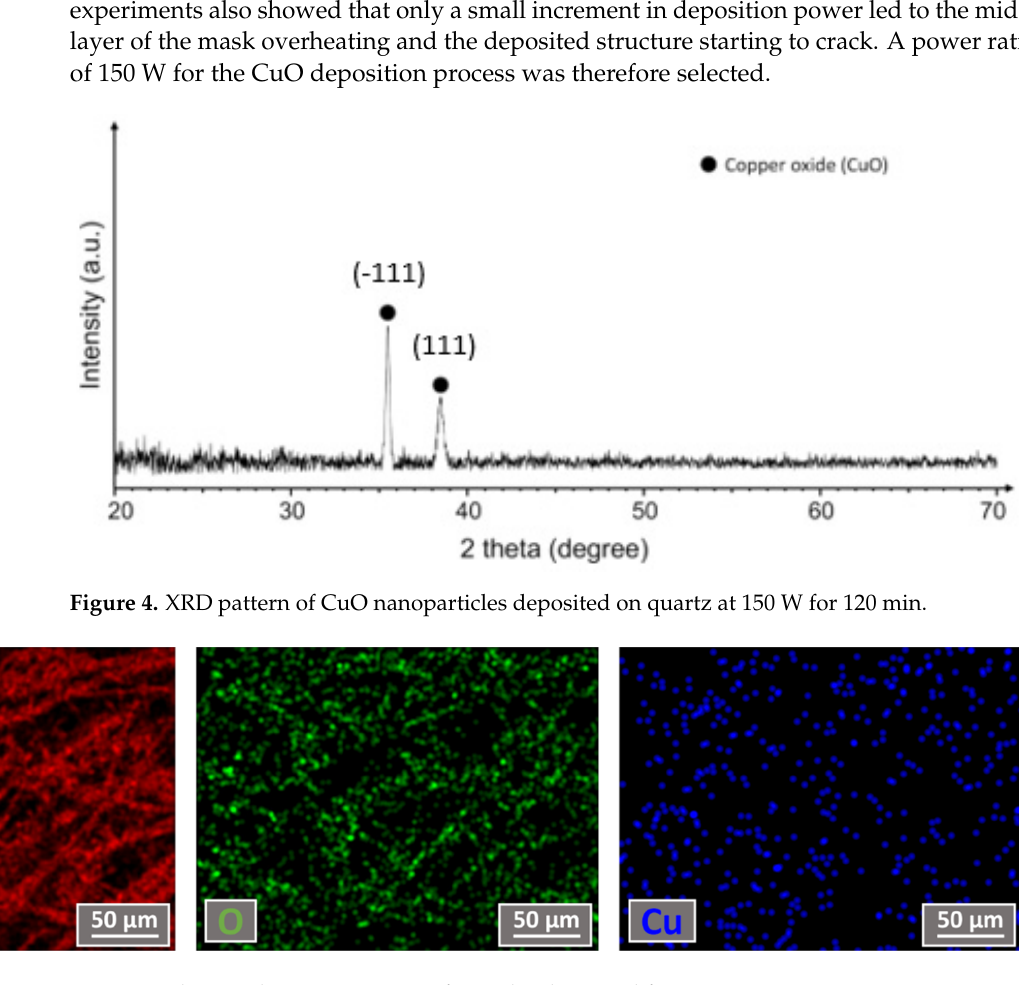
Figure 5. Elemental mapping views of samples deposited for 120 min.